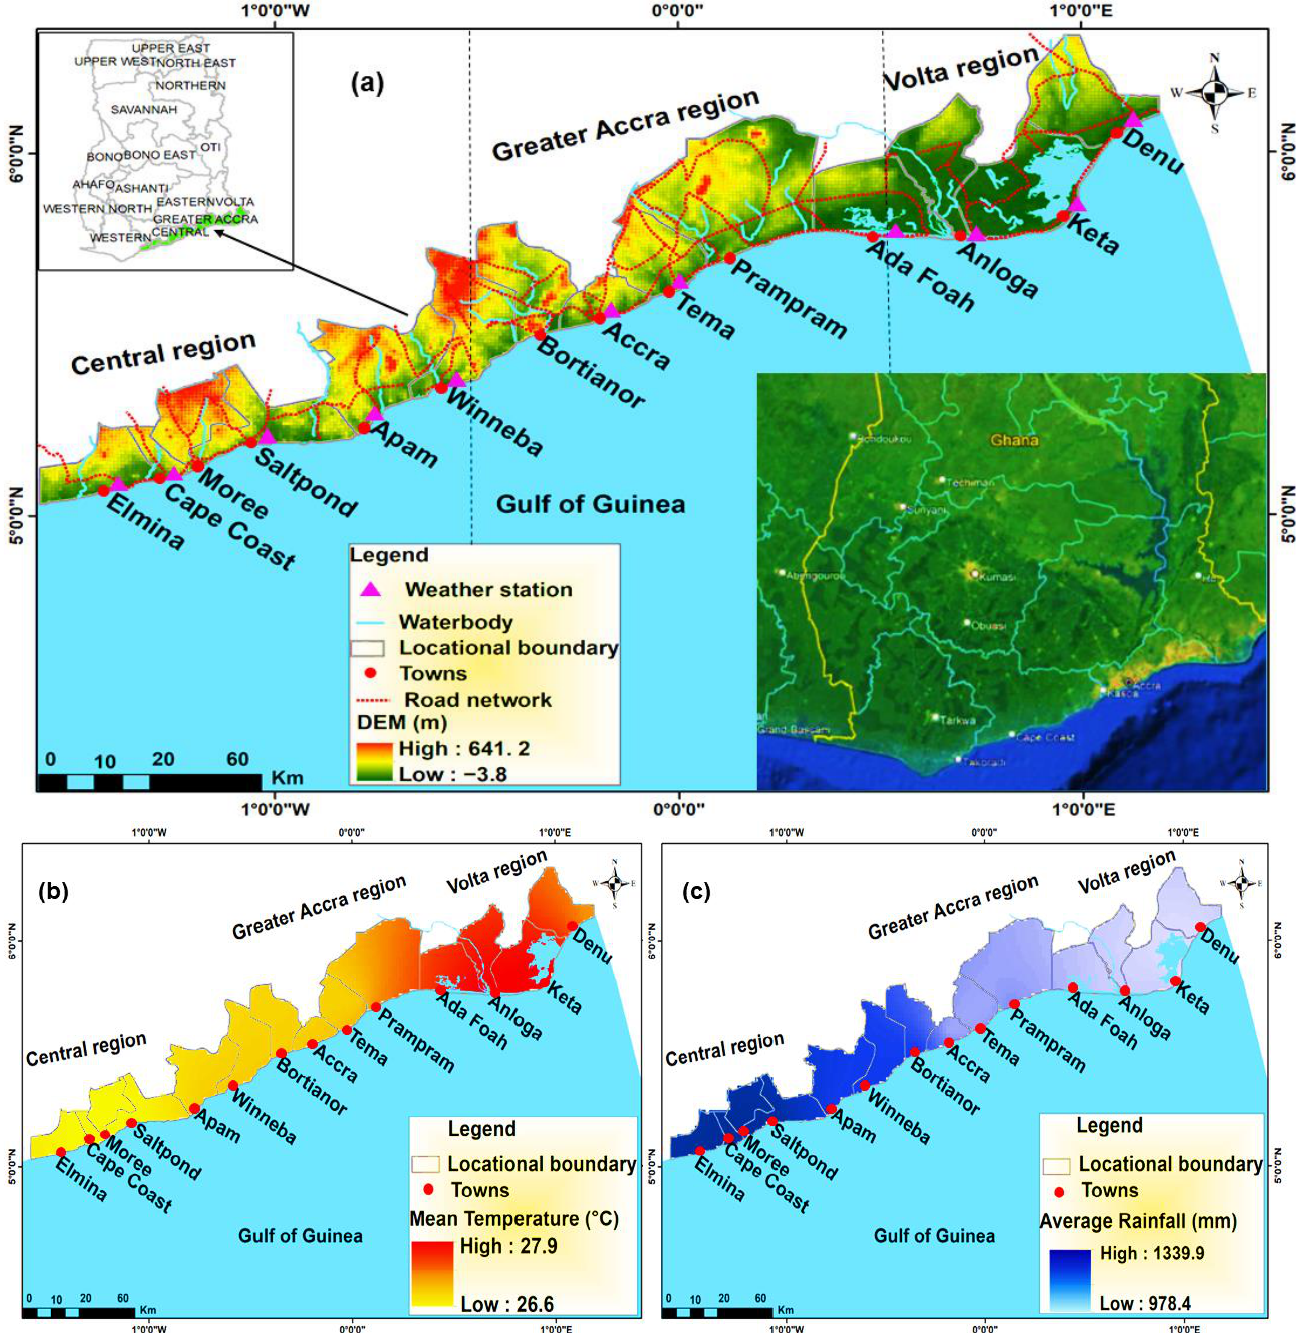
Figure 1. Map showing the location of the coastal Savannah agroecological zone, elevation, major towns, and measurement stations ( a ); average annual rainfall (from 1981 to 2021) ( b ); mean annual temperature (from 1981 to 2021) ( c ).